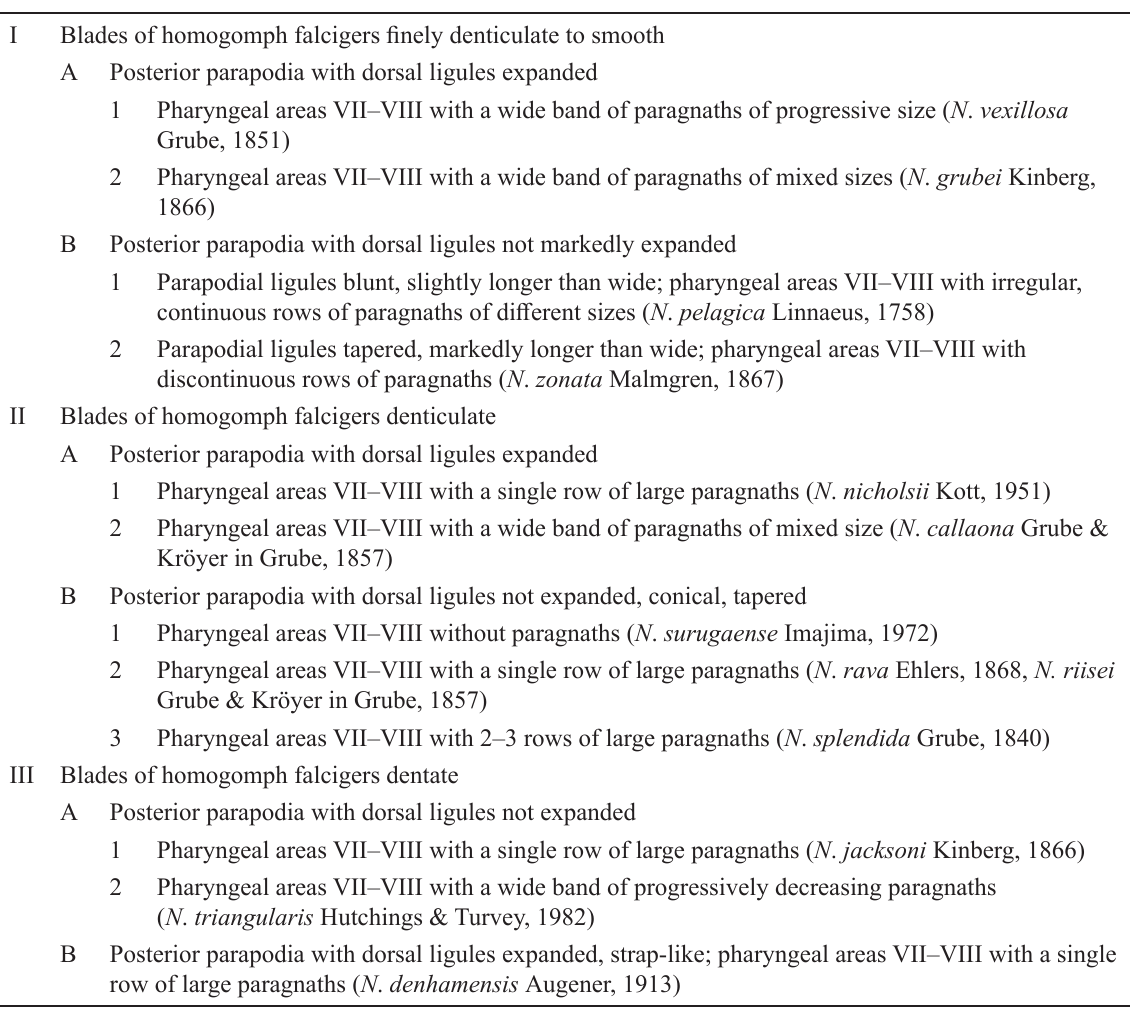
Table 1. Species groups of Nereis Linnaeus, 1758 and representative species based on descriptions or redescriptions